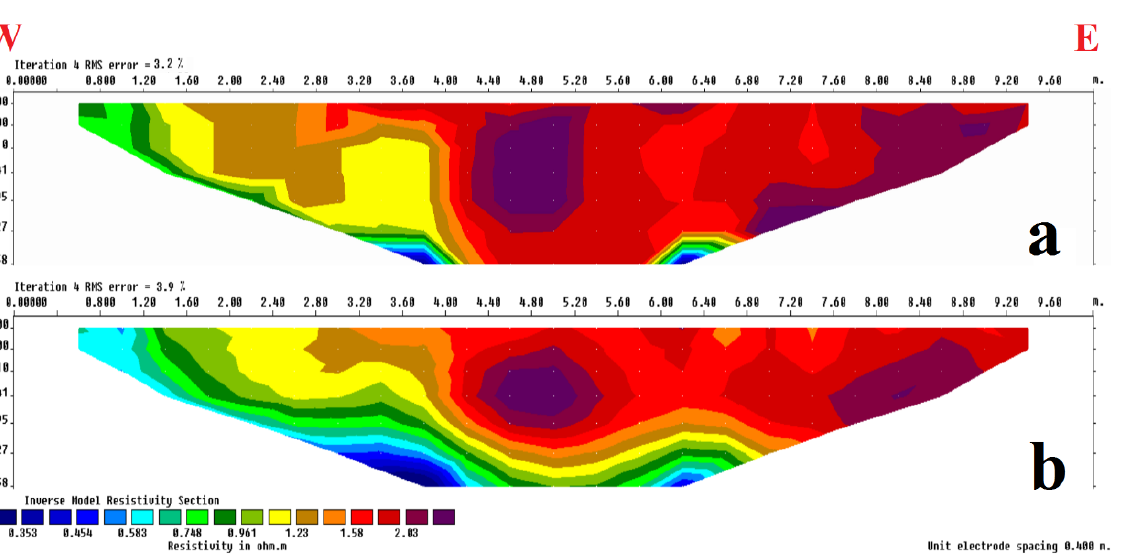
Figure 7. ( a ) Spontaneous potential map and ( b ) calculated apparent resistivity gradient map of the same plot surveyed at Farm A. Initial examination of the SP and RG maps shown in Figure 7 reveals a significant discrepancy between the results of the methods. For instance, the elongated high anomaly in the central part of the SP map has disappeared completely from the RG map. Its location is occupied by a gradual decrease in the apparent resistivity towards the southern parts of the surveyed plot. Similarly, it was clearly observed during the fieldwork that the ap- parent resistivity values recorded in areas characterized by dense vegetation were always high in contrast to SP. For better understanding, combining results of more than one geophysical method is a common practice to reduce the ambiguities in data interpretation. Thus, the results ob- tained from the three surveys on Farm A were compiled into one figure (Figure 8). The green and the light blue curves shown in the upper part of the figure represent lateral variations of SP and RG values, respectively. Both curves were plotted at their exact loca- tion along the ERT cross-section. This compilation revealed several important points re- garding the response of each method to the changes in soil texture and structure. First, the two curves (Figure 8) conspicuously confirm the discrepancy between the SP and RG readings, i.e., when SP shows high values at a particular location along the profile, GR correspondingly shows low values for the same location, and vice versa. Usu- ally, the SP and GR curves diverge opposite permeable freshwater sand and converge in